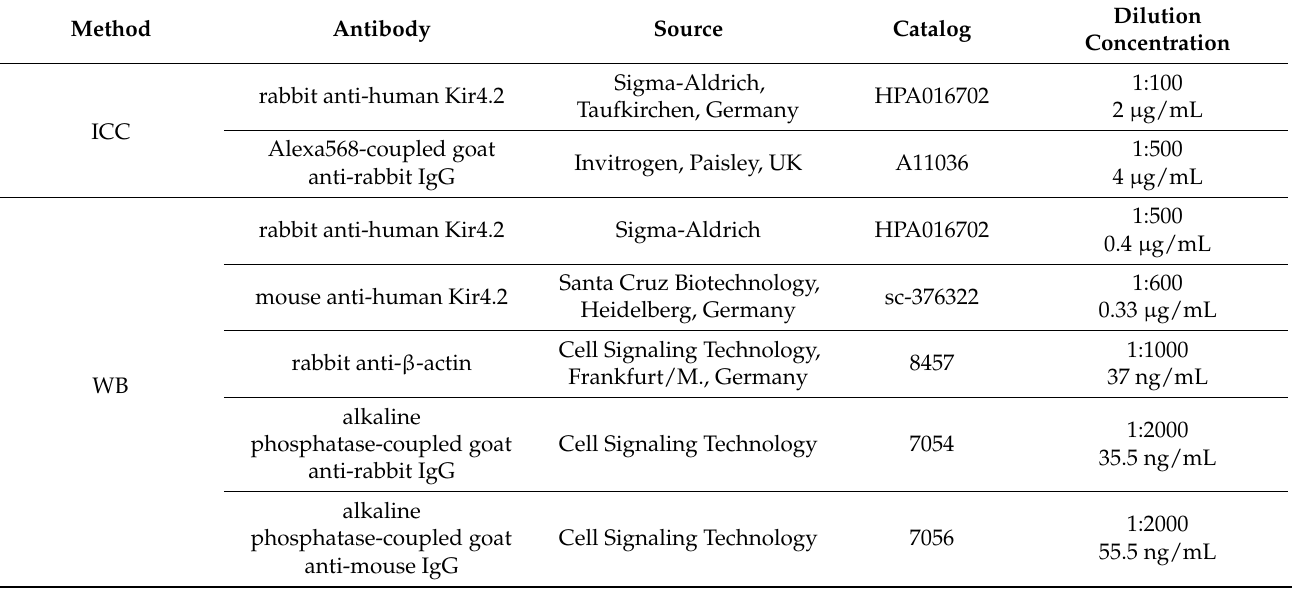
Table 2. Antibodies used in immunocytochemistry (ICC) and western blot (WB)